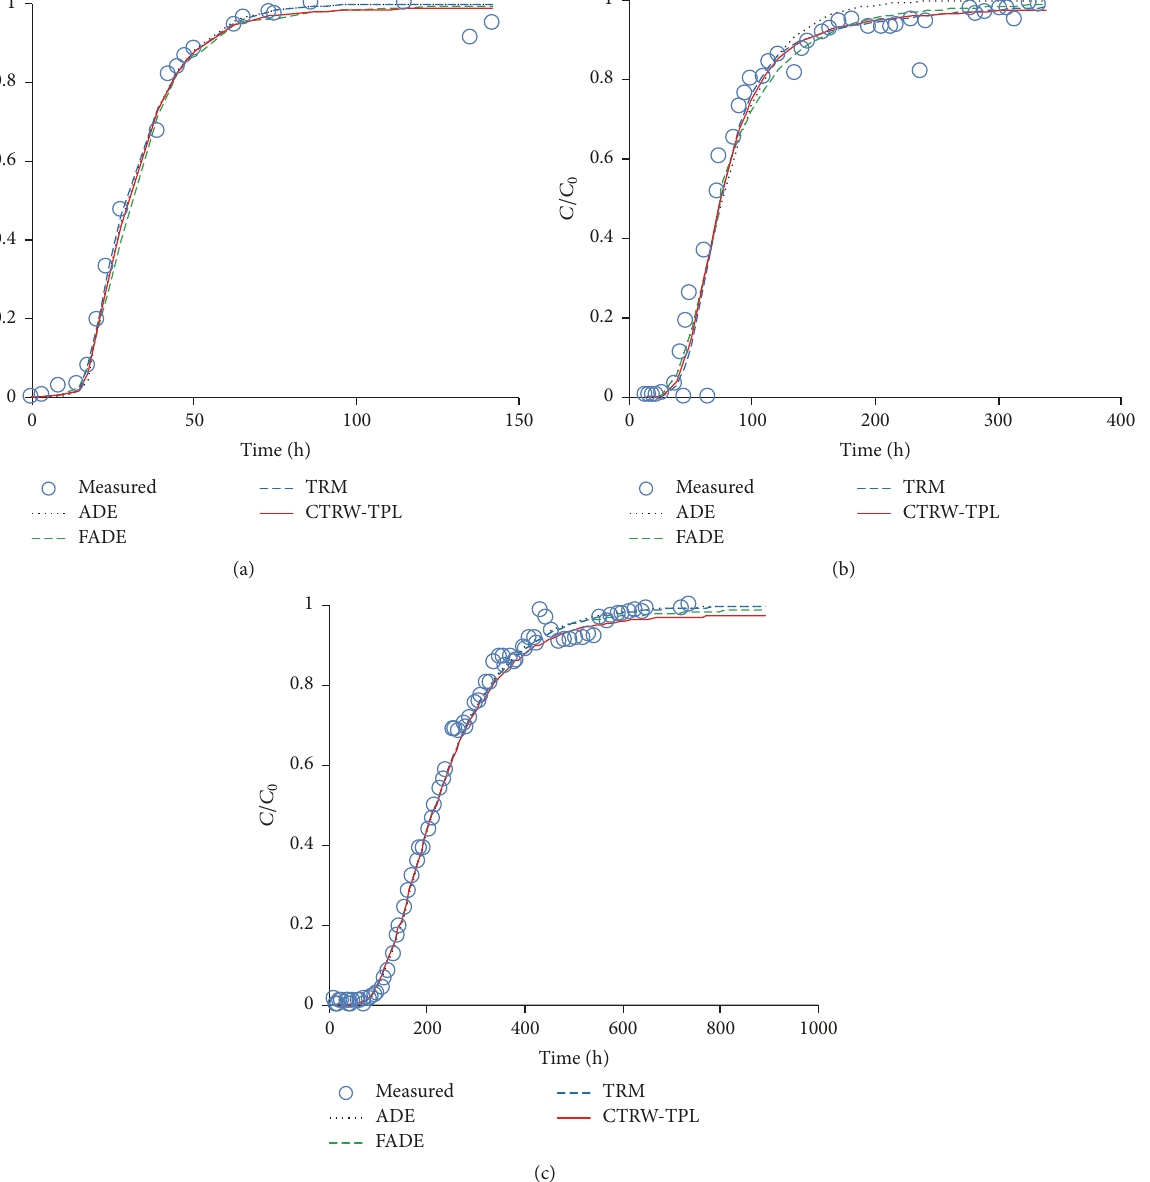
Figure 5: Three sets of measured breakthrough curves fitted with ADE, FADE, TRM, and CTRW (based on TPL), for the homogeneous, saturated, and rough wall soil columns with the same inner column diameter (14cm) but different column lengths: (a) 3cm; (b) 5cm; (c) 8